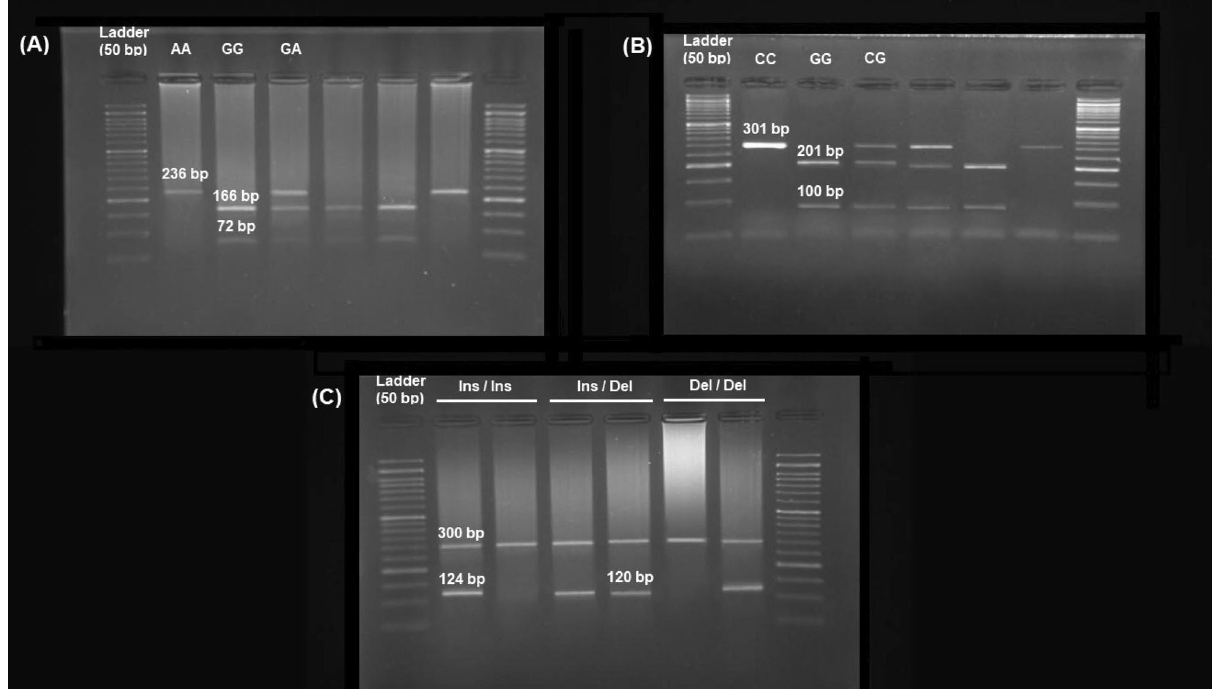
Figure 2. Gel photograph of SLC11A1 –rs3731864 G/A ( A ), –rs3731865 G/C ( B ), and –rs17235416 + TGTG/− TGTG ( C )